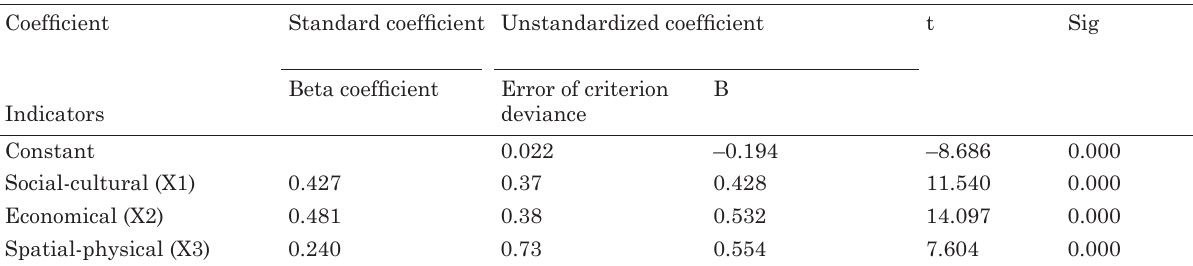
Table 7. Regressionanalysis statistics of the neighborhoods development indicators